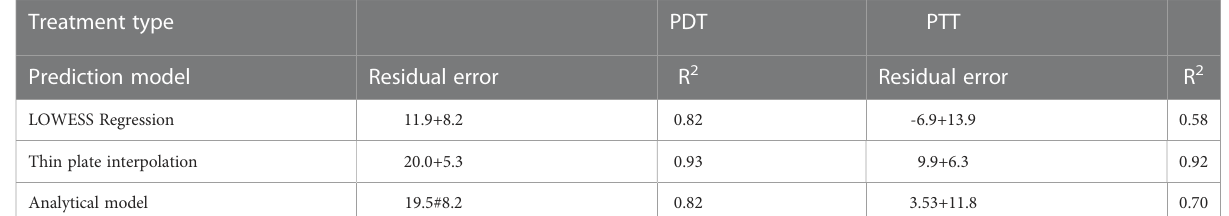
TABLE 2 Test error analysis results, goodness of fi t. Treatment